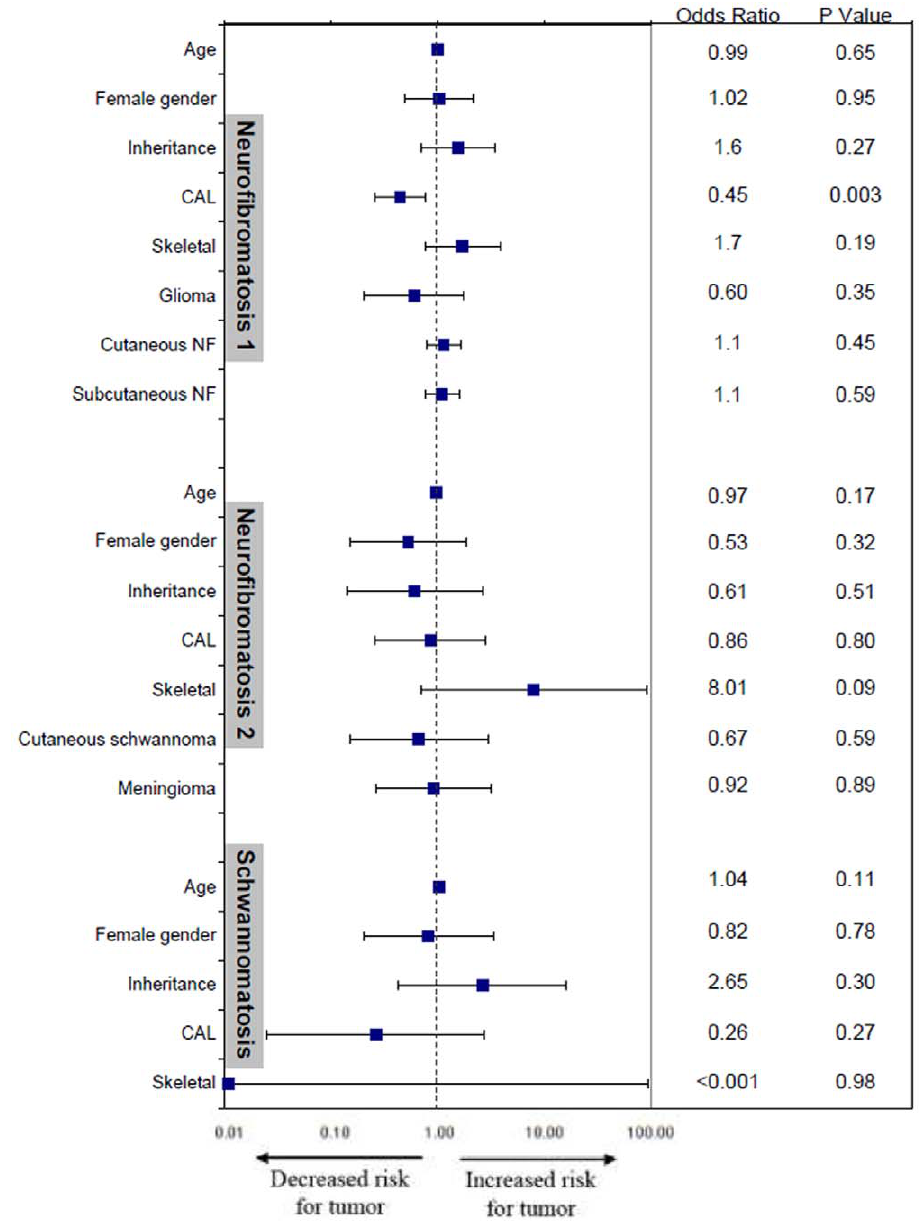
Figure 3 . Odds ratios for the presence of internal nerve sheath tumors. Odds ratio for the presence of internal nerve sheath tumors in NF1, NF2, and schwannomatosis patients, according to clinical and demographic characteristics. Odds ratios and 95% confidence intervals were calculated with the use of logistic regression analsysis. Squares indicate odds ratios and horizontal lines indicate 95% confidence intervals. P values are for the odds ratios.